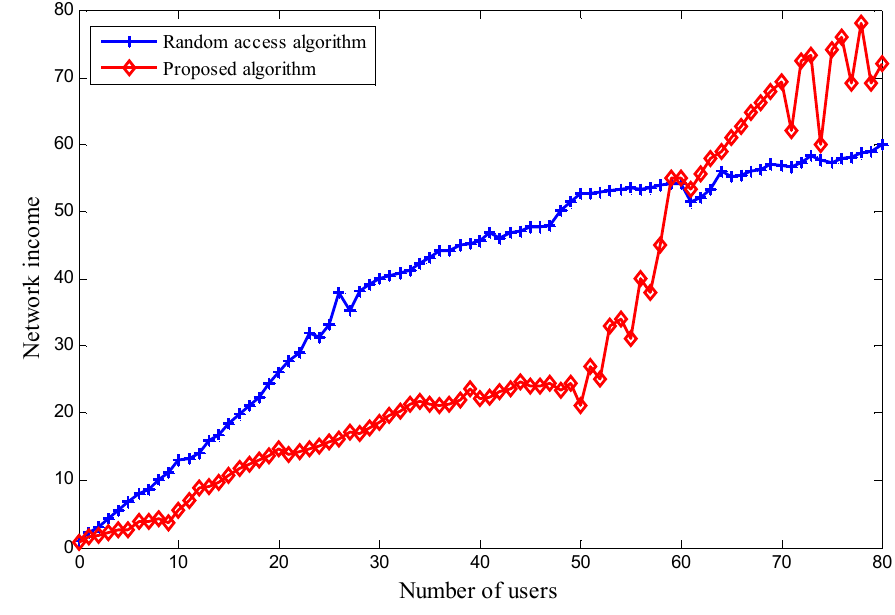
Figure 10. The ratio of congestion rate and network income.